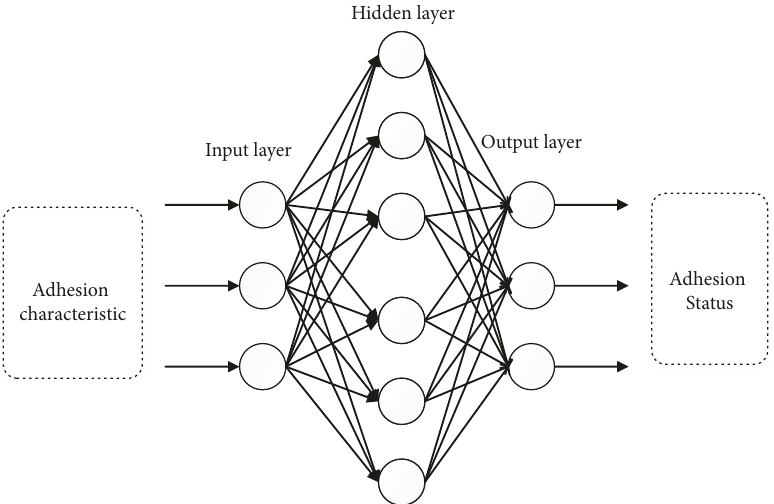
Figure 5: Schematic of the structure of the BP neural